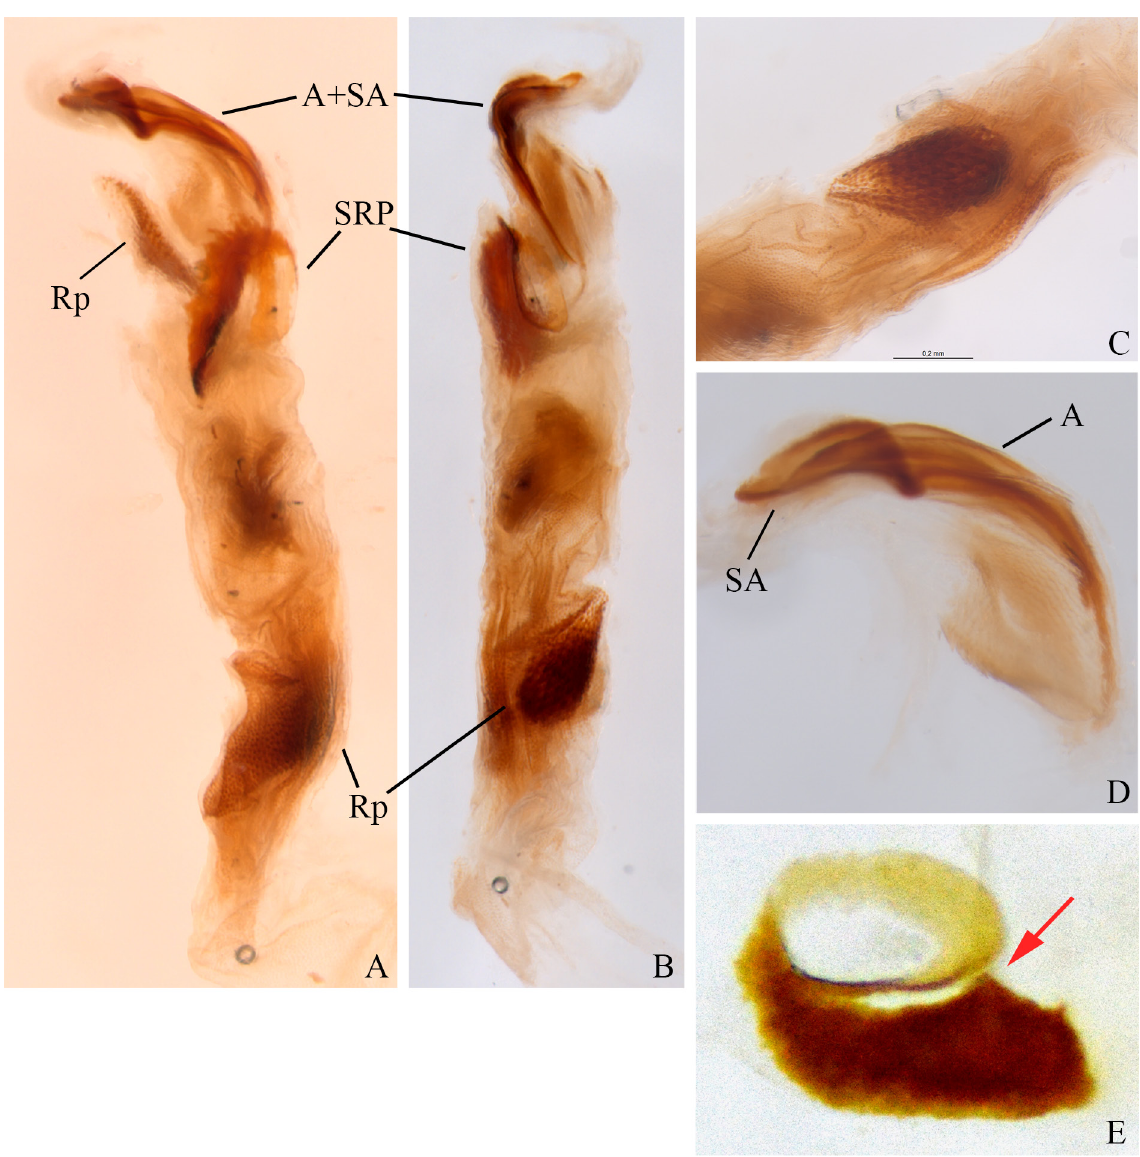
Fig. 25. Internal sac of Streblopus punctatus (Balthasar, 1938). A‒B . General aspect before dissection. C . Raspule. D . Apical and subapical sclerites. E . Superior right peripheral sclerite. Arrow indicates a triangular area of a more sclerotized tegument that is probably homologous to a similar triangular area on the SRP of S. opatroides van Lansberge, 1874. Abbreviations: A = axial sclerite; Rp = raspule; SA = subaxial sclerite; SRP = superior right peripheral sclerite; T =